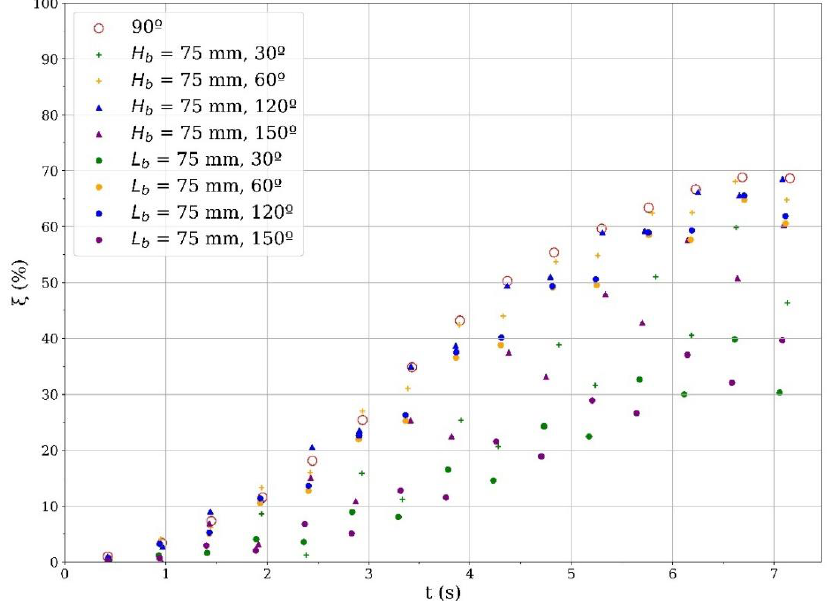
Figure 7. Energy dissipation rate.